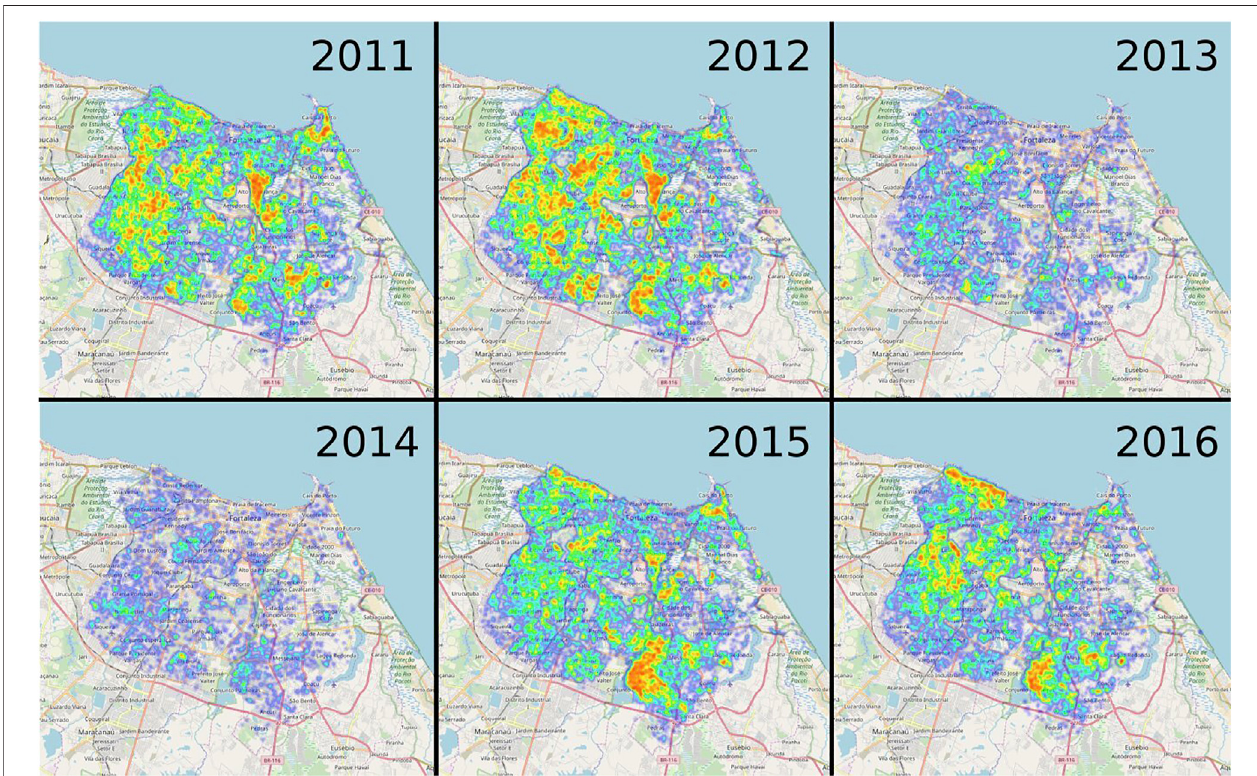
FIGURE 2 | Dengue outbreaks in Fortaleza from 2011 until 2016. Heat maps of all dengue cases in Fortaleza from 2011 until 2016. Blue areas correspond to regions with a low incidence of dengue cases whereas red ones indicate large dengue outbreaks. As depicted, the heatmaps show a clear the difference between epidemic years (2011, 2012, 2015, and 2016) and non-epidemic years (2013 and